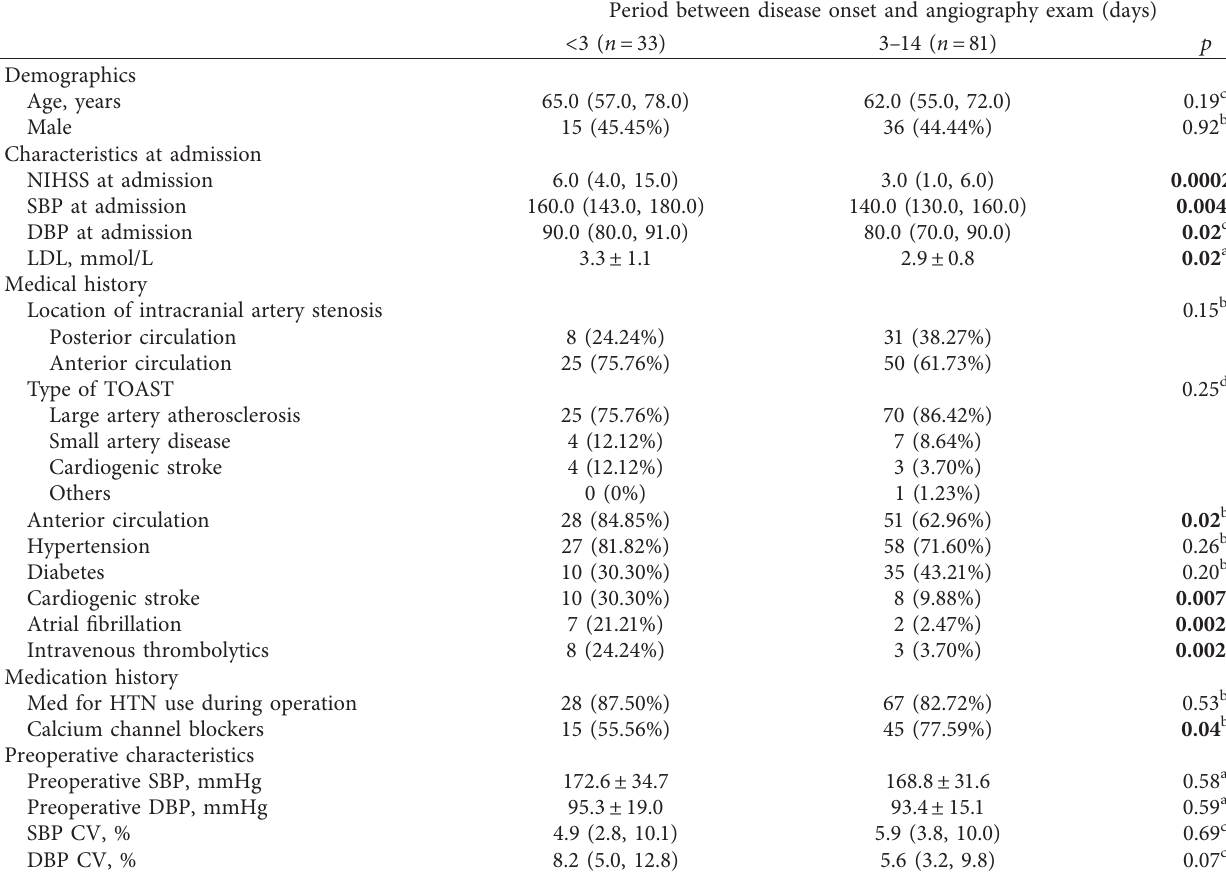
Table 1: Demographic and clinical characteristics of study